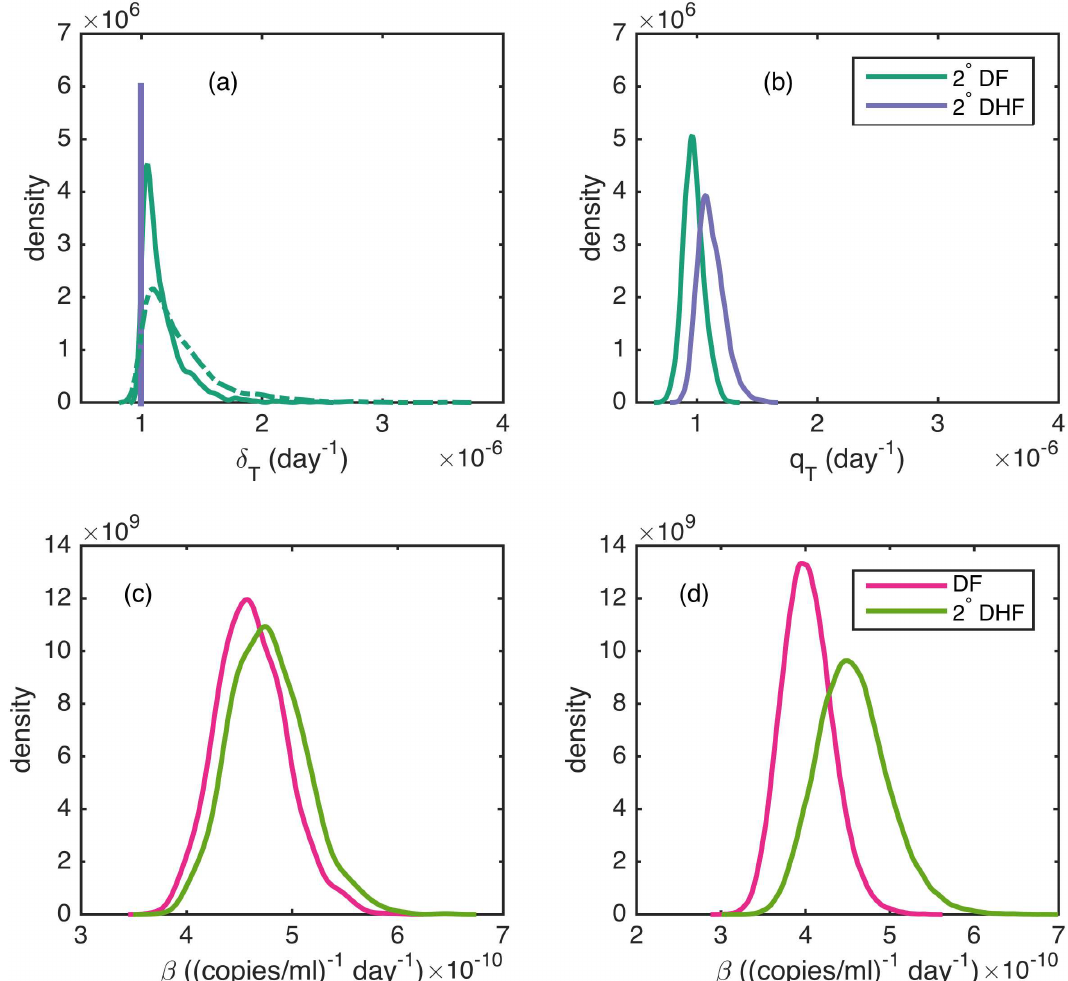
Fig 4. Parameter estimates from the clinical manifestation models. (a) Density estimates of T-cell clearancerate d T DF for models OAS 1 (solid green) and OAS 2 (dashed green), alongsidethe assignedvalue of d (purple line). (b) Density T DHF estimates of T-cell activation rates q and q for model OAS 2 . (c) Density estimates of viral infectivity rates β DF and T DF T DHF b for model ADE . (d) Density estimates of β DF and b when the ADE model is fitted to the subset of the data for SI DHF SI DHF individuals with a detected viral peak. The medianparameter estimate and 95% posterior credible interval (in parentheses) (cid:0) d of the differenceof the parameter estimates shown in (a-d) are: (a) model OAS 1 : d 1.1 × 10 − 7 (3.8 × 10 − 9 , 6.5 × T DF T DHF (cid:0) d (cid:0) q 10 − 7 ). model OAS 2 : d : 2.1 × 10 − 7 (7.2 × 10 − 9 , 1.1 × 10 − 6 ). (b) q : 1.4 × 10 − 7 (2.8 × 10 − 8 , 3.1 × 10 − 7 ). T DF T DHF T DHF T DF